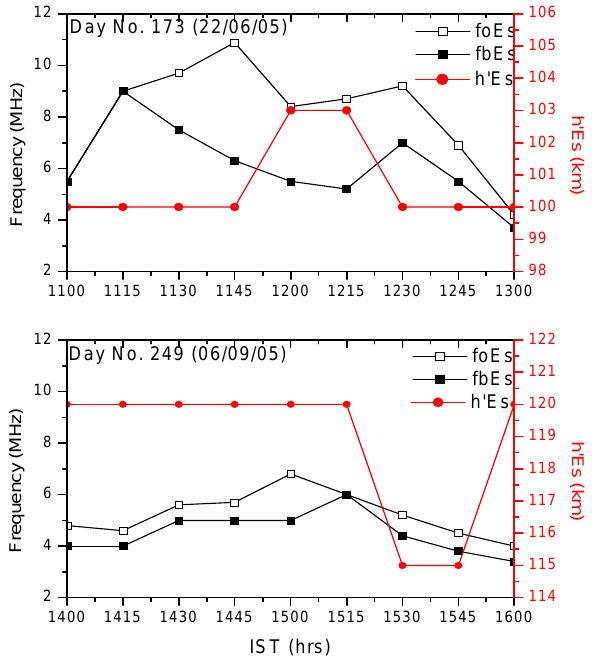
Fig. 8. Time variations of f o E S , f b E S and h 0 E S for pre noon (top panel) and post noon (bottom panel)